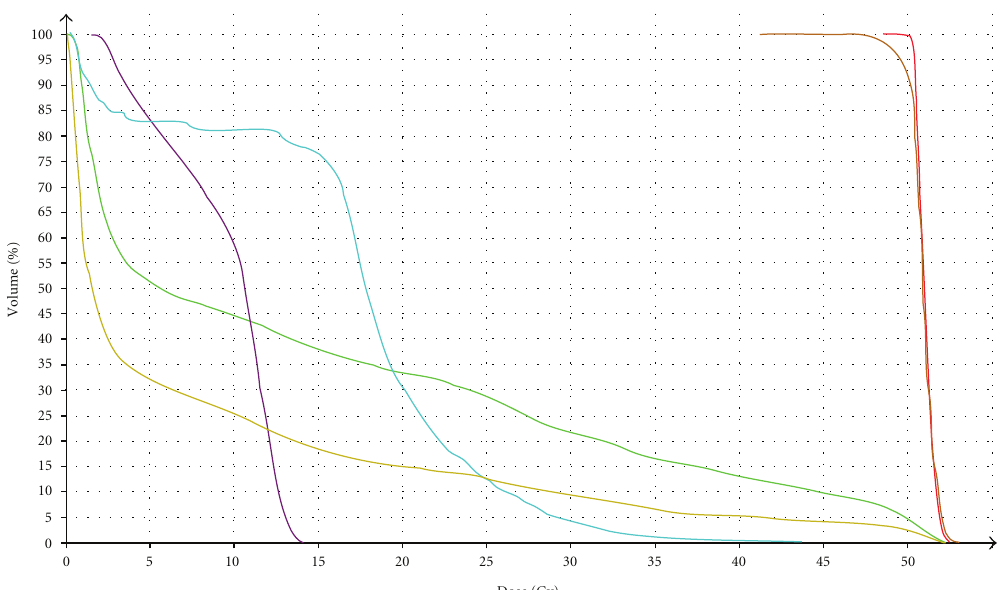
Figure 2: Dose-volume histogram: liver (green), left kidney (purple), body (pink), spinal cord (blue), CTV (red), and PTV (orange).